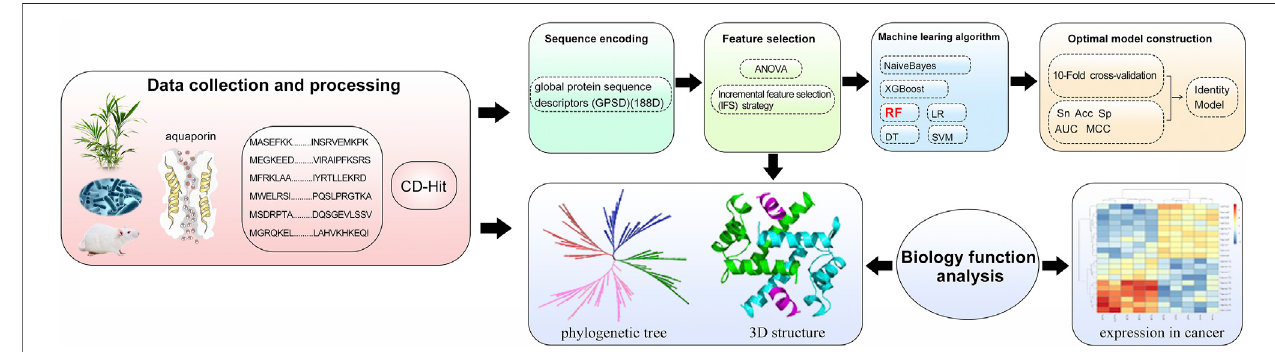
FIGURE 1 | The whole framework of the method iAQPs-RF to identify the